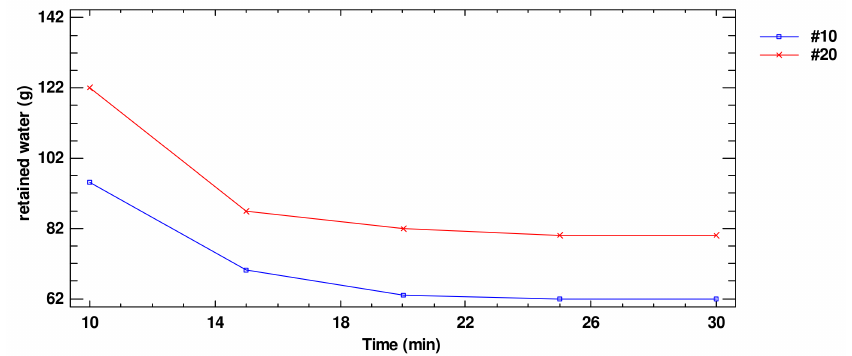
Figure 4. Retained water as a function of